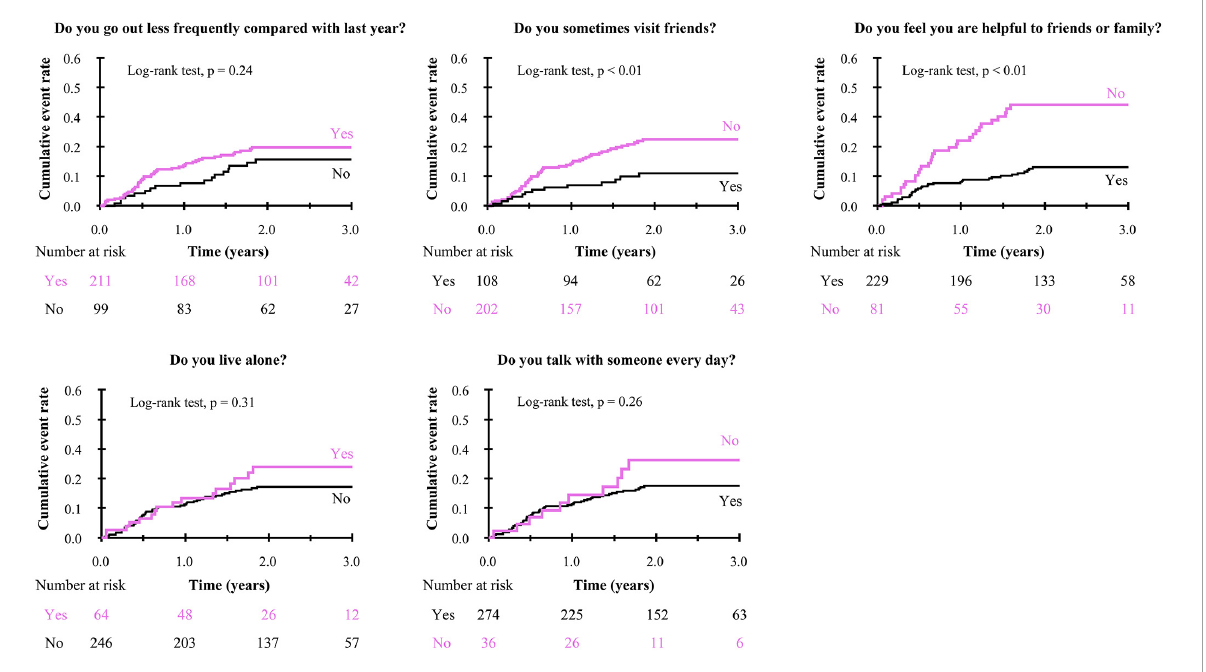
FIGURE3 Kaplan-Meier curve for the composite event in negative/positive response to each of Makizako’s 5